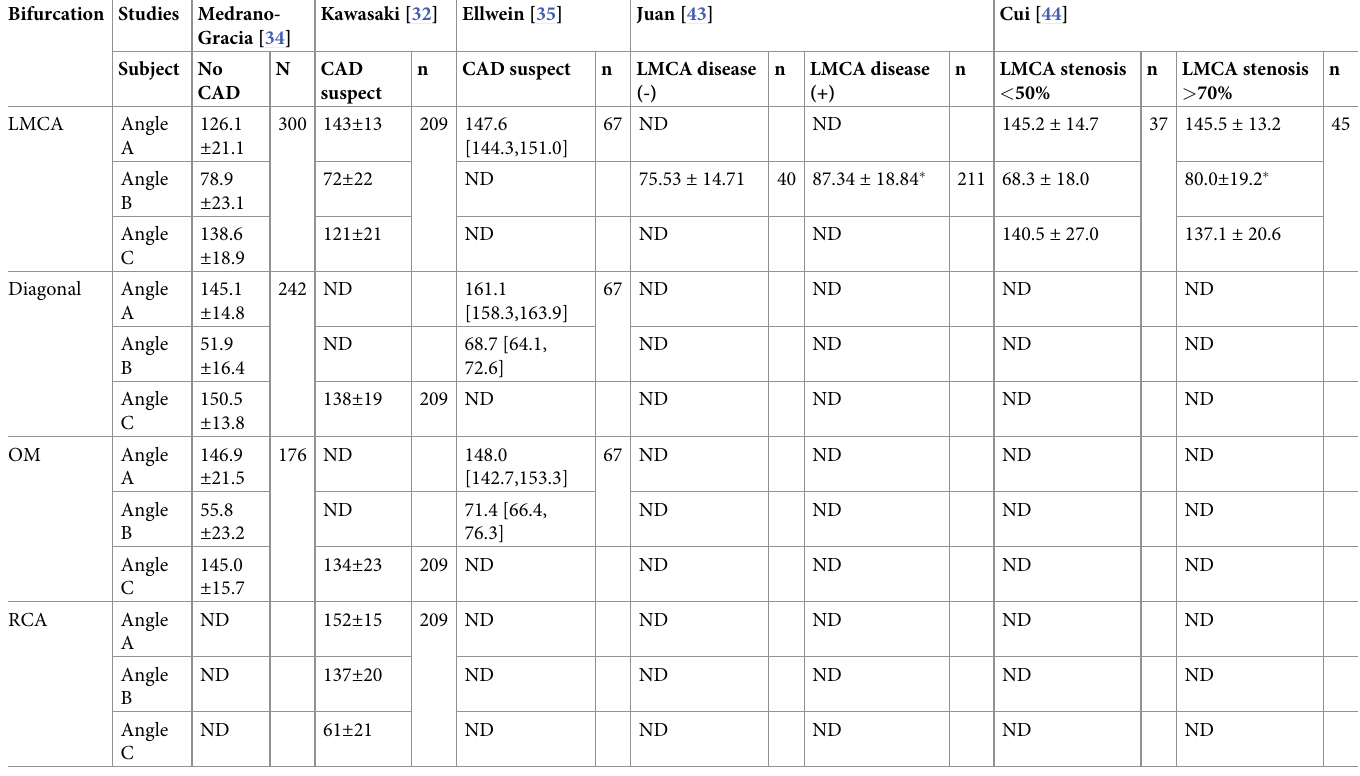
LMCA: left main coronary artery, OM: Oblique marginal branch, RCA: Right coronary artery, CAD: Coronary artery disease, ND: Not described, Values are expressed as mean ± standard deviation or median [1 st , 3 rd quartile] � p < 0.05 in the comparison between the groups divided by the presence of LMCA stenosis.